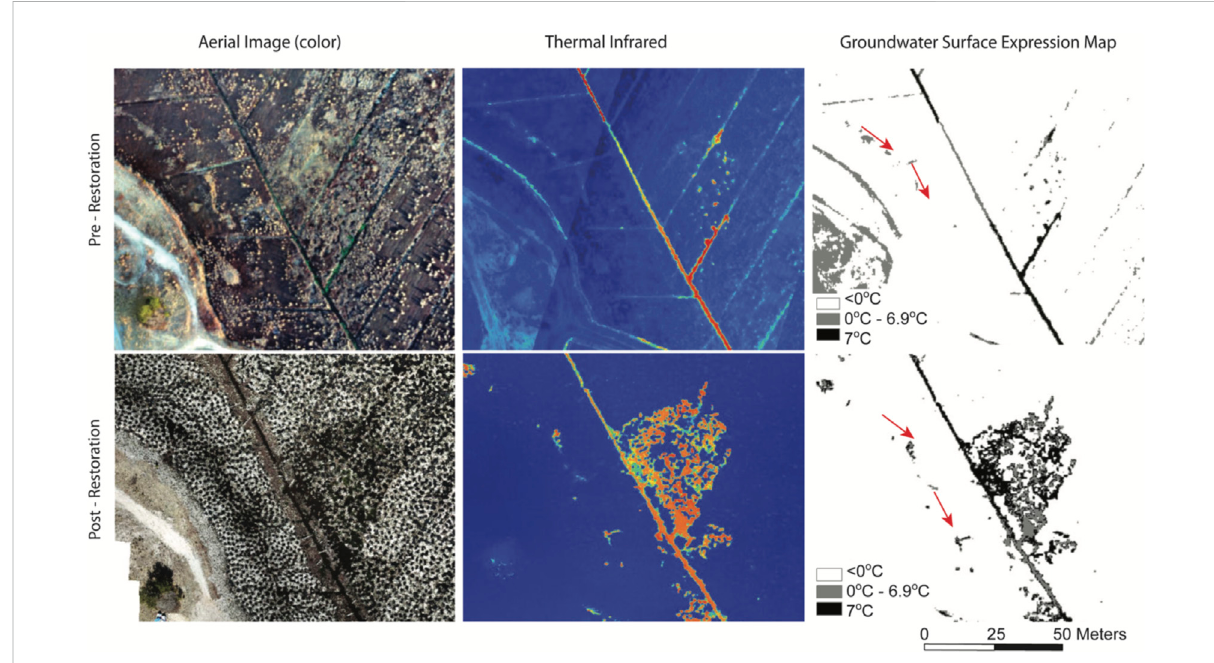
FIGURE 6 Comparative UAS imagery from pre-restoration (top row) to post-restoration at Foothills Preserve, from left to right: (left) plain light (RGB image),(center)thermalinfrared,and(right)surfaceexpressionofgroundwater(black=groundwaterandgray=mixingzone).Thisareahaddiscrete individual seeps before restoration, which merged into a single, much larger area seep complex during restoration. Red arrows indicate the hypothesized original stream channel fl ow